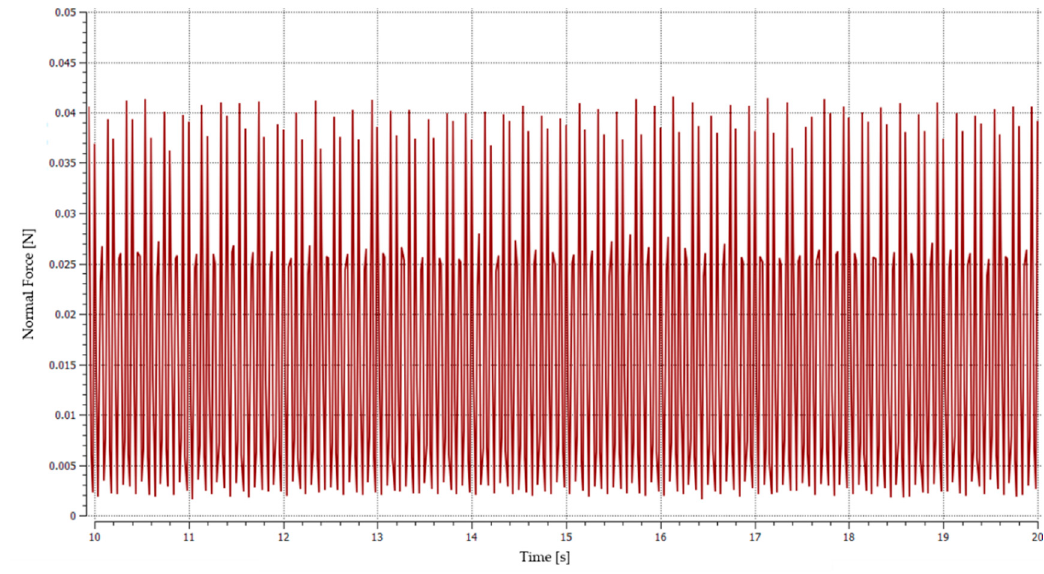
Figure 5. Average forces acting on the fruit in the normal direction vibrating transport.